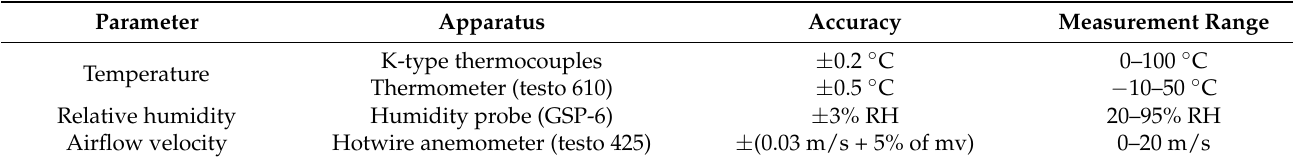
Figure 6. Measurement location. Table 2. Specification of experimental apparatus. Table 2. Specification of experimental apparatus.